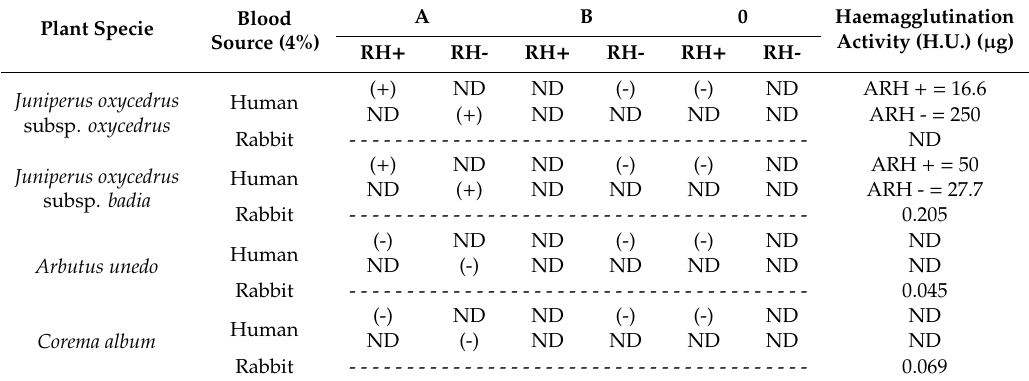
Table 1. Haemagglutination activity detection in human and rabbit erythrocytes. Plant